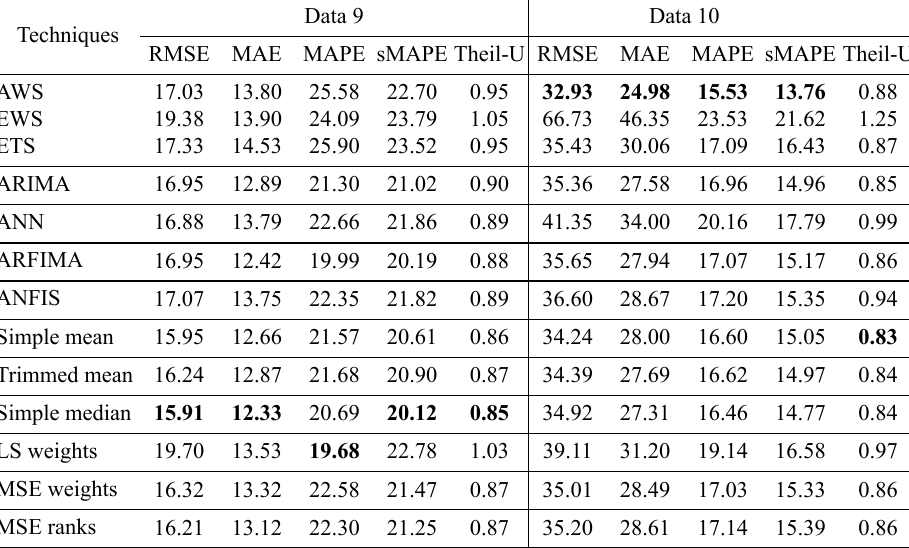
Table 8. Forecasting results of the single models and combining methods for Data 9 and 10 Data 9 Data Techniques